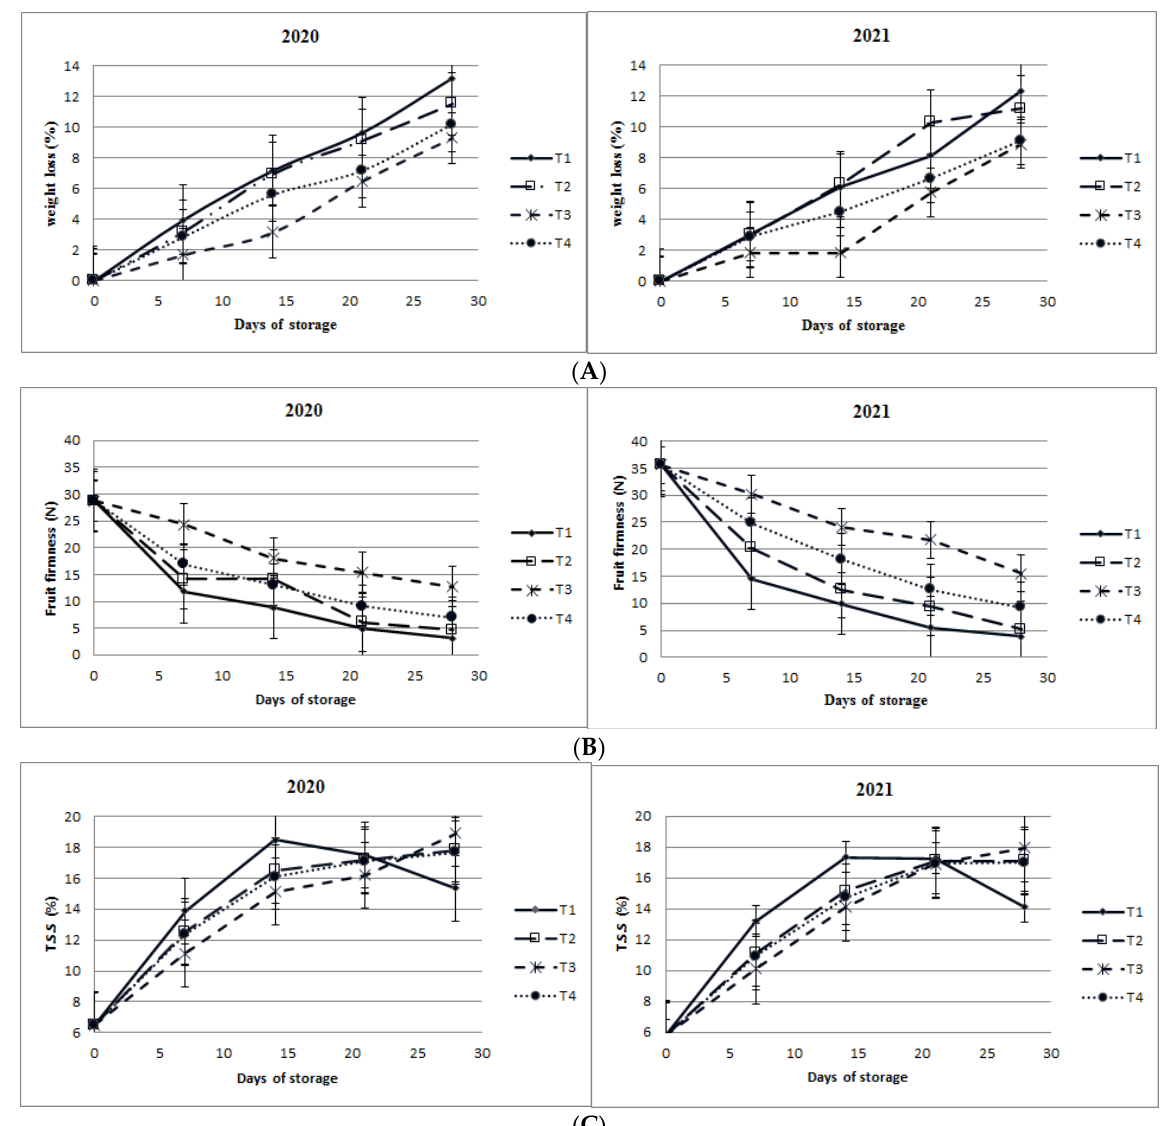
Figure 2. Effect of hot water treatment and chitosan coating on weight loss ( A ), fruit firmness ( B ), and total soluble solids (T.S.S) ( C ) of mango fruits during storage at 13 ± 0.5 °C and 85–90% relative humidity (RH) for 28 days during 2020 and 2021 seasons. Values are means ± SE from three replicates. Statistical analysis was performed using LSD test.